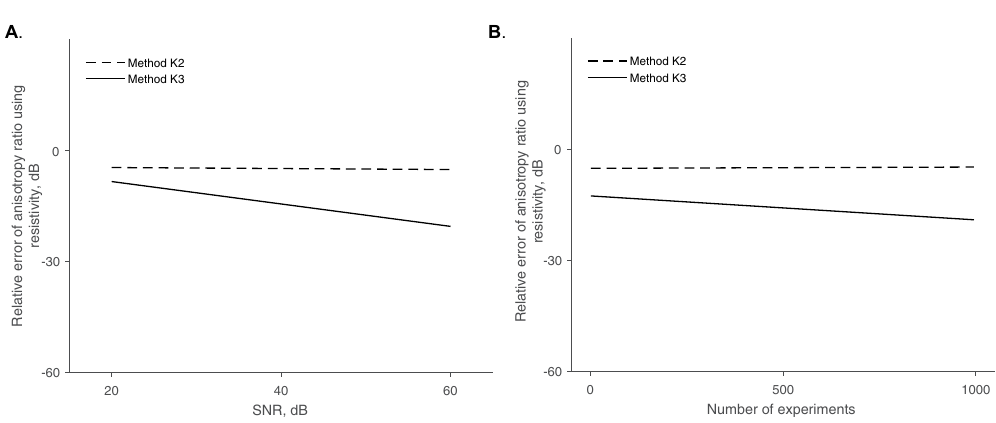
Figure 5. Comparison between methods K2 (dashed black line) and K3 (solid black line) estimating the resistivity anisotropy ratio α 2 ˆ while changing the signal-to-noise ratio (SNR) and keeping the number of measurements constant at M = 10 ( A ); and then while changing the number of measurements performed and keeping constant the SNR = 40 dB ( B ). Rates of decline of the relative error values between the estimated 2 ˆ α and true α 2 resistivity anisotropy ratio value are graphically shown, calculated with a linear